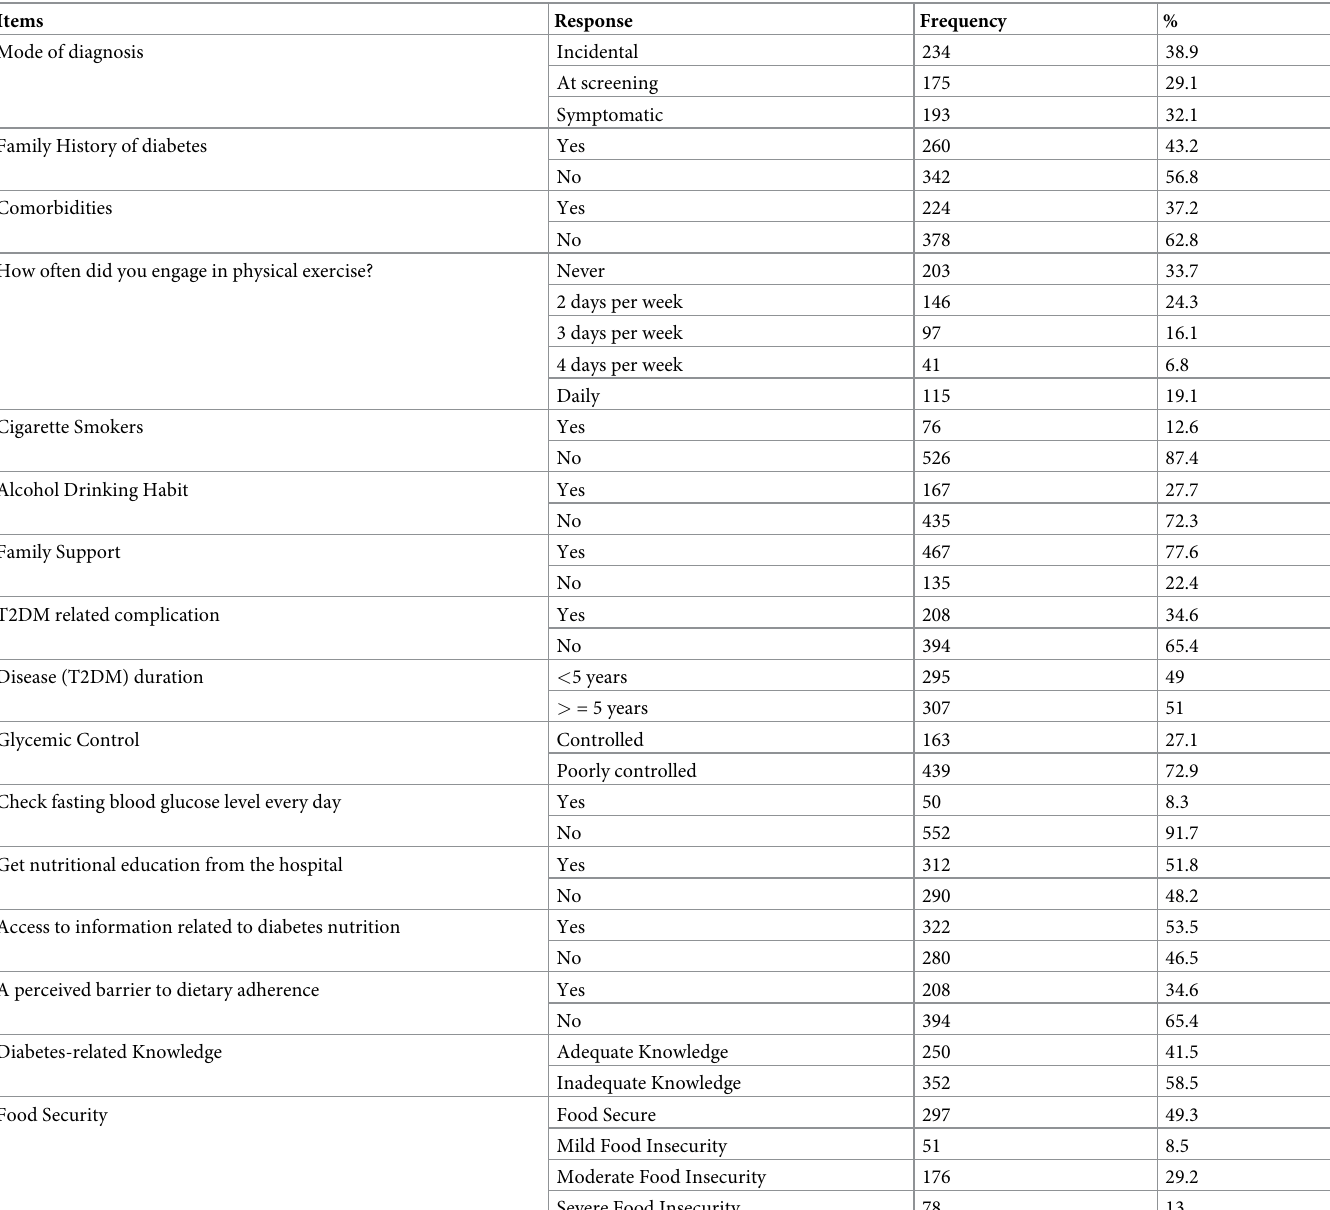
Table 2. Clinical and other related characteristics of patients with T2DM who had regular medical check-ups at selected public hospitals in Addis Ababa, 2019.